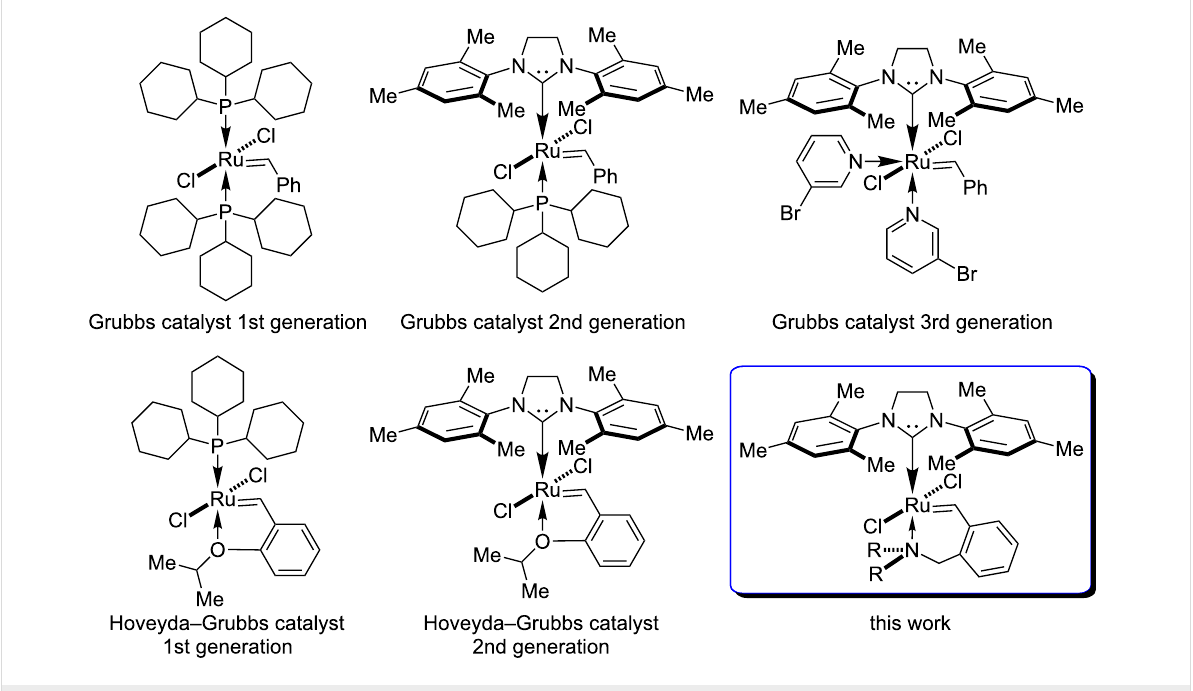
Figure 1: Commercially available ruthenium catalysts for metathesis